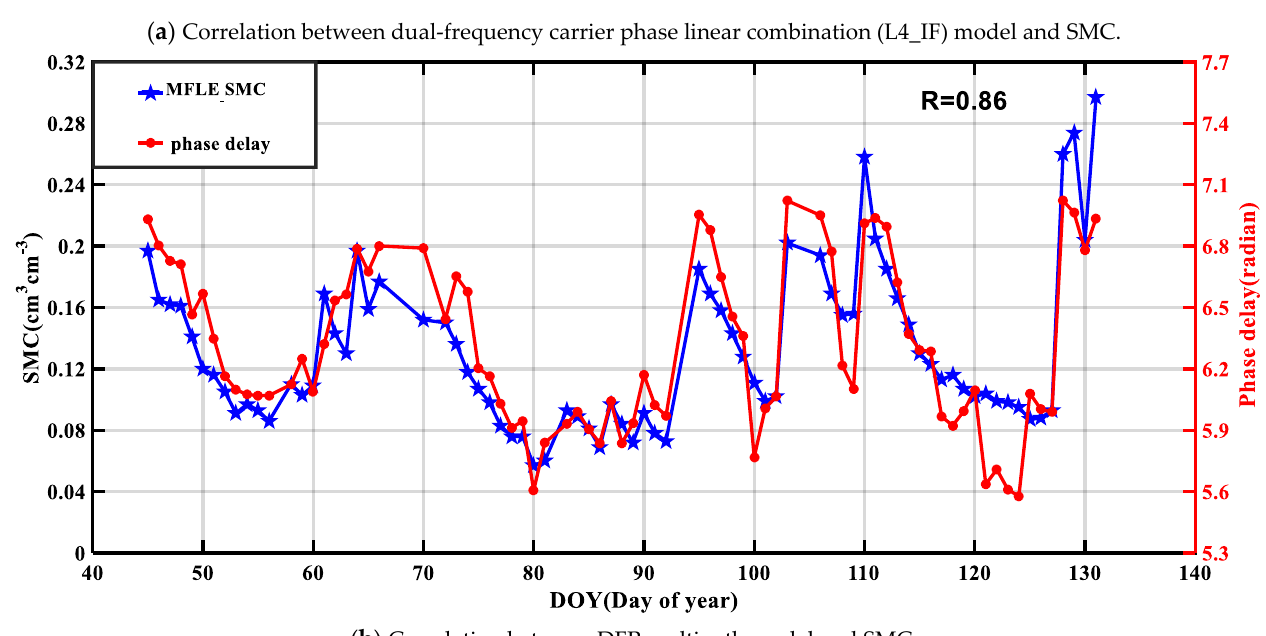
Figure 14. MFLE station; correlation between Delay Phase and SMC.